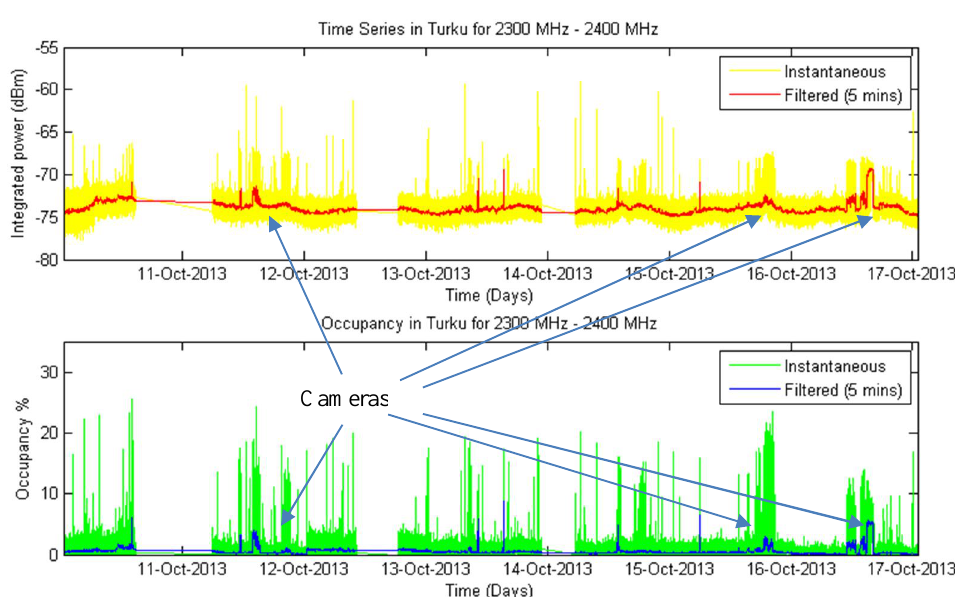
Figure 5 . Integrated power time series and percentage occupancy at Turku (Oct 10 th – 17 th 2013)